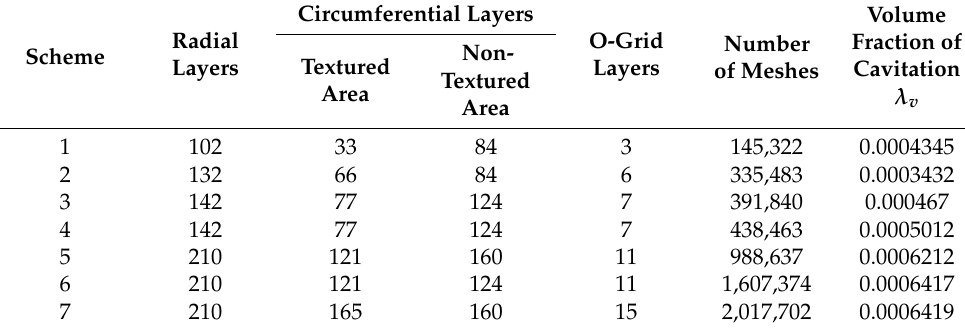
Figure 8. Structural grid of oil film.